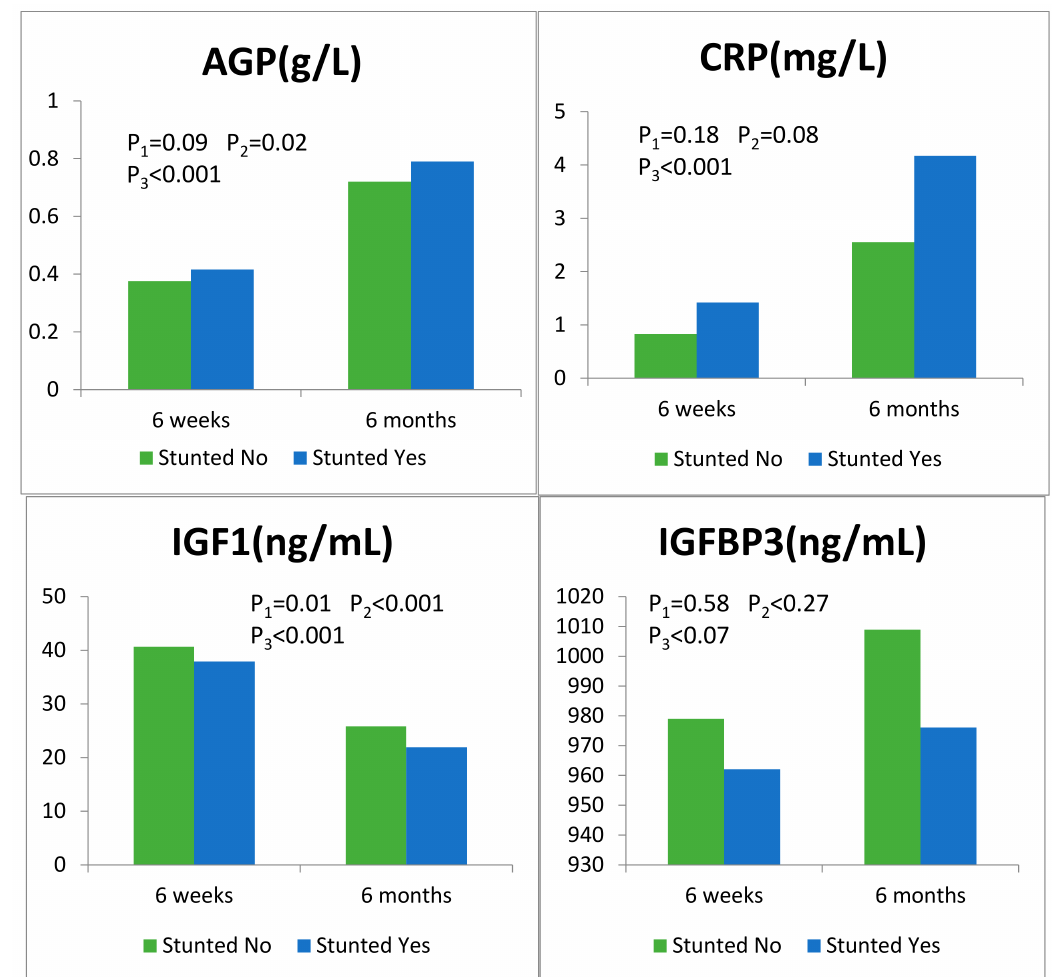
Figure 2. Levels of inflammatory (C-reactive protein (CRP), alpha-1-acid glycoprotein (AGP)) and growth (insulin-like growth factor-1 (IGF-1), insulin-like growth factor binding protein-3 (IGFBP-3)) biomarkers at 6 weeks and 6 months in Tanzanian children who did or did not develop subsequent stunting. Please note: In this figure “stunted” is defined as children who developed stunting during the follow-up